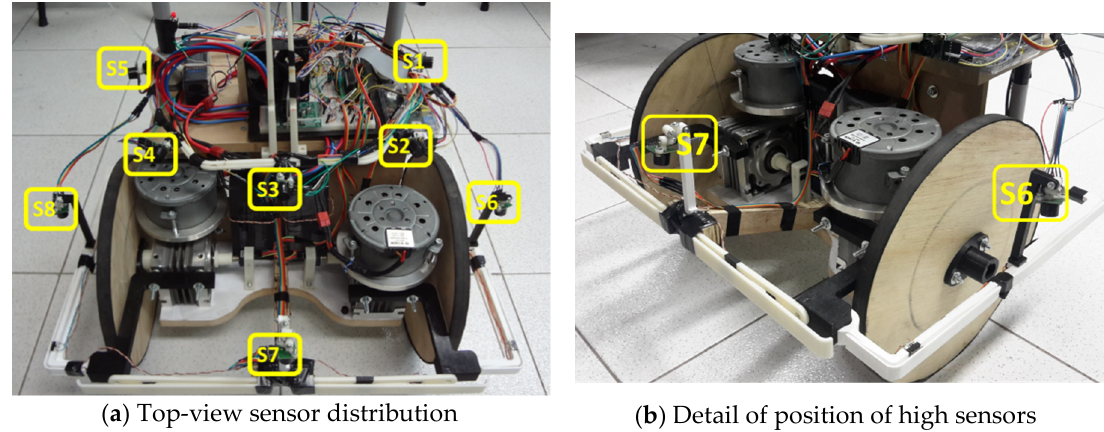
Figure 2. Distribution of ultrasonic sensor at the prototype.